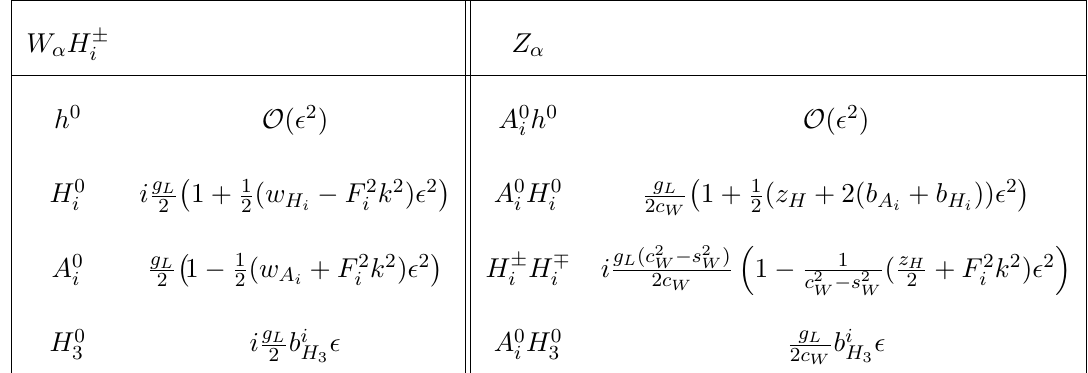
Table 19 . Couplings of W (cid:11) and Z (cid:11) with two scalars H 1 H 2 . The couplings with i 6 = j are O ( (cid:15) 2 ) and thus irrelevant here. These couplings are multiplied by the di(cid:11)erence of the incoming momenta of the two scalars ( p H (cid:0) p H ) (cid:11) where H 1 = H 0 and H 2 = H + in the former 2 1